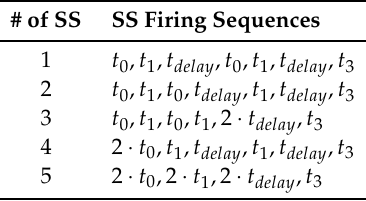
Table 3. Possible firing sequences (SS, Static Schedule) for initial marking vector [ p 0 p 1 p 2 p ] = [ 0 0 2 0 ] under single-server semantics.